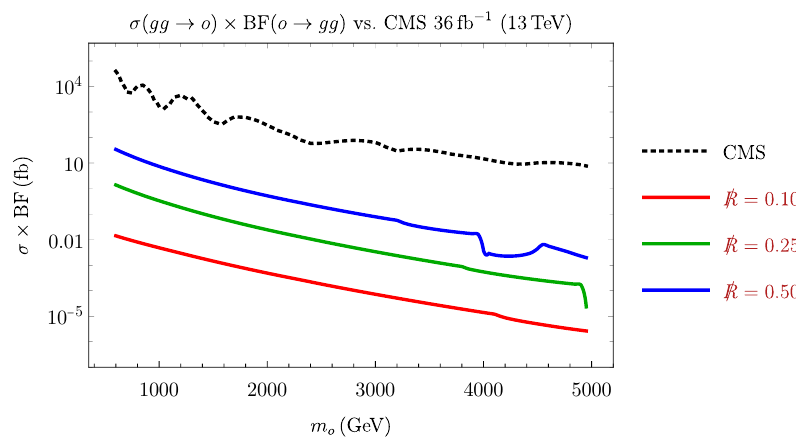
Figure 13. Cross sections in Benchmarks 1–3 of single pseudoscalar sgluon production with subsequent decay to gluons compared to exclusion bound from CMS 36 fb − 1 ( 13 TeV) dijet resonance search for color-octet scalars assuming σ ( o ) = σ eff ( gg → o ) and BF ( o → gg ) = 1 .